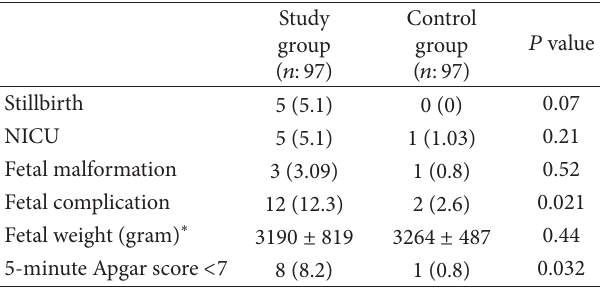
T 3: Fetal and neonatal